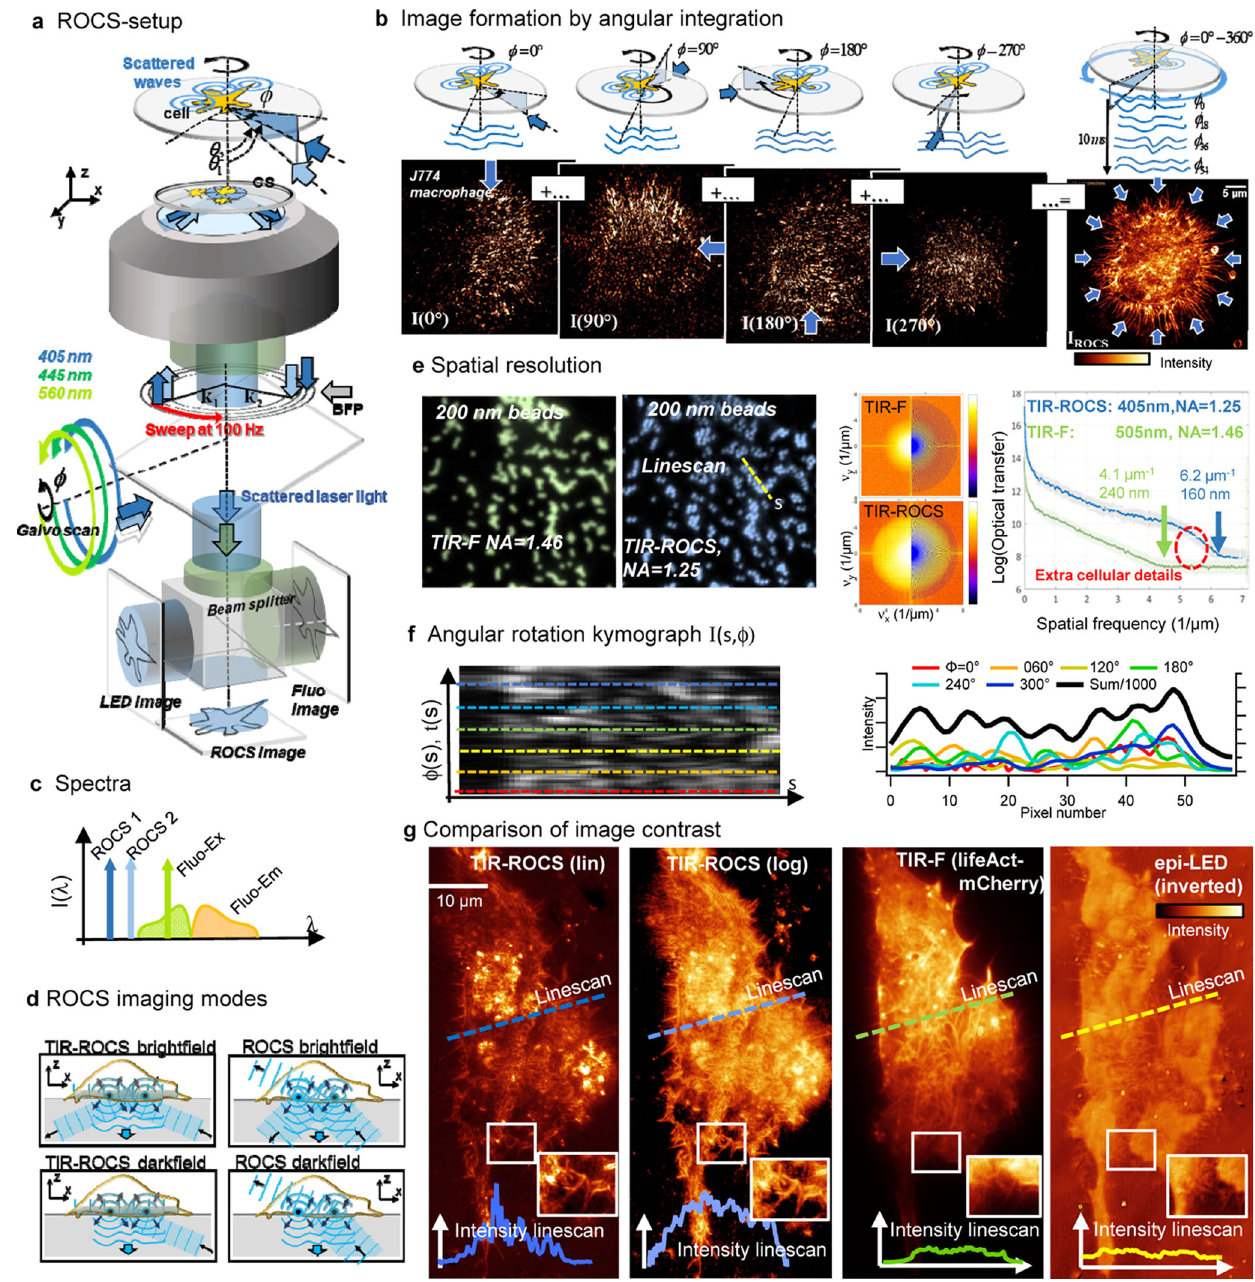
Fig. 1 Principles of ROCS microscopy. a Setup scheme of ROCS microscope with azimuthal laser beam rotation at 100 Hz incident under high polar angles θ . Scattered laser light is imaged onto a camera integrating over sweep time. b ROCS images form upon the full 360° sweep of a laser beam. Coherent images from different azimuthal directions (see blue arrows) form speckle patterns, which generate the fi nal ROCS image by incoherent superposition. c Wavelength spectra I( λ ) for ROCS illumination and detection at the same wavelength (405 nm or 445nm), without exciting fl uorescence. Fluorescence excitation with laser (560 nm), fl uorescence emission at orange wavelengths. d Four possible illumination and detection modes in ROCS microscopy, where TIR-ROCS in dark fi eld mode provides the highest contrast. e Parallel TIR-imaging of 200 nm PS beads in fl uorescence mode (green at 505 nm, at NA = 1.46) and ROCS mode (blue at 405 nm, NA = 1.2). Spatial frequency spectra for TIR-F and TIR-ROCS are averaged in azimuthal direction (logarithmic intensity, STD in light gray), shown by green and blue line scans. TIR-F provides 240 nm spatial resolution, TIR-ROCS achieves 160 nm. f Kymograph I(s, ϕ ) along direction s (dashed line in ROCS image). For totally n = 72 raw images from different azimuthal angles ϕ the speckle patterns show limited angular correlations. Below: Six line scans I(s, ϕ n ) at six angles with resulting sum intensity. g Comparison of image contrast for different imaging modes of a HeLa cell. Left to right: TIR-ROCS image (linear intensity) recorded within 10 ms at 445 nm with large dynamic range. The logarithmic intensity image shows lower intensity structures ( fi lopodia) with strong signal contrast. The TIR-F image (200 ms integration time) with Lifeact-mCherry actin labeling reveals similar, but not the same structures (see ROI). An incoherent epi-image (inverted) of a blue LED (435 nm) reveals again different cellular details at low contrast and dynamic range (purple line). Source data are provided as a Source Data fi le.